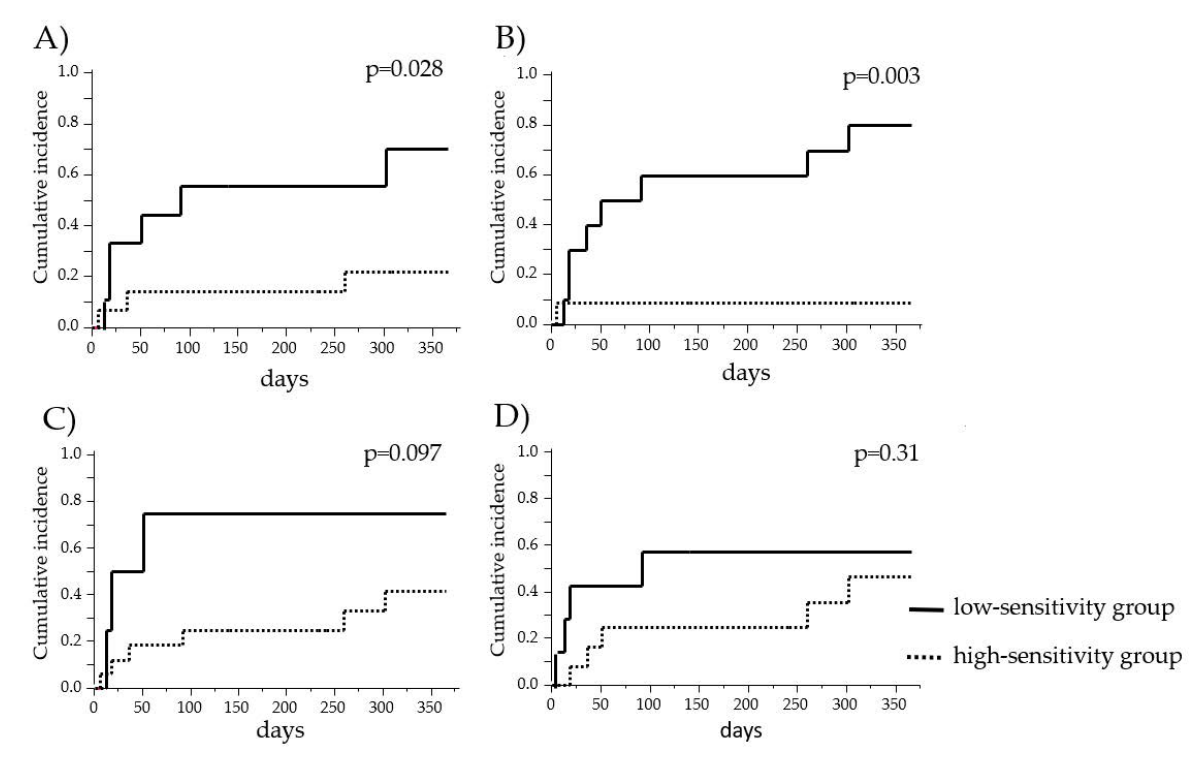
Figure 3. Comparison of the cumulative incidence of AR between the PBMC high-sensitivity group and the PBMC low-sensitivity group to GCs. The cumulative incidences of AR in the PBMC high-sensitivity group and the PBMC low- sensitivity group to COR before transplantation ( A ), MPSL before transplantation ( B ), COR after transplantation ( C ), and MPSL after transplantation ( D ) were estimated. The solid lines and dashed lines indicate the data for the low-sensitivity and high-sensitivity groups,